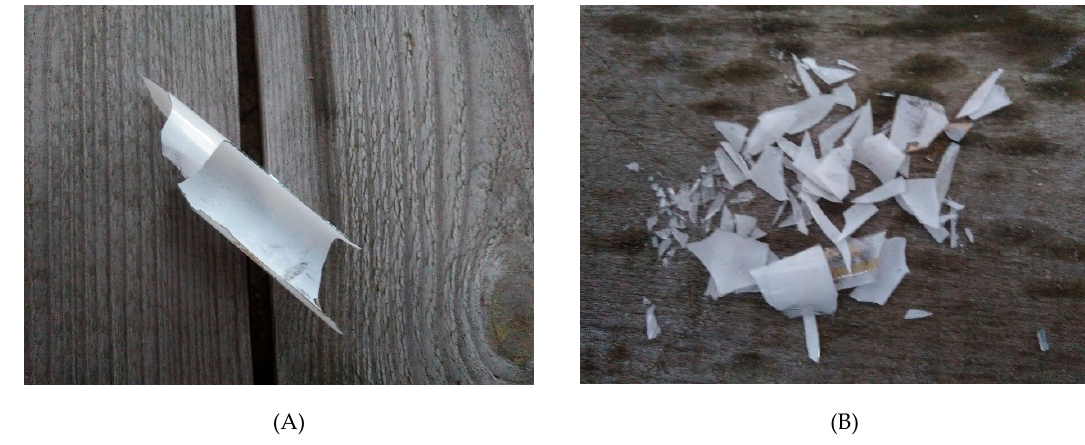
Figure 1. Waste from glass ( A ) glass separated from lighting equipment; ( B ) aggregate made from waste. 111